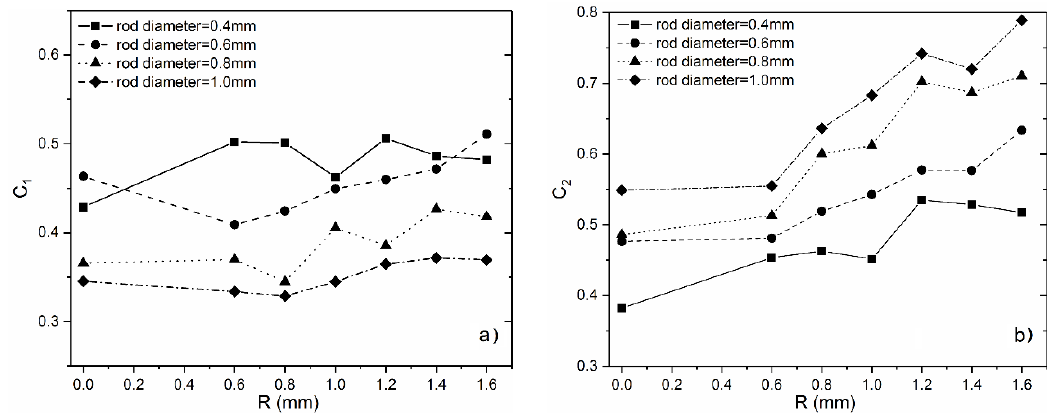
Figure 7. Values of 𝐶 1 and 𝐶 2 with the increase of optimized-radius. Table 3. Characteristics of cell structure and mechanical properties of open cellular Ti6Al4V samples. Rod Diameter, Samples